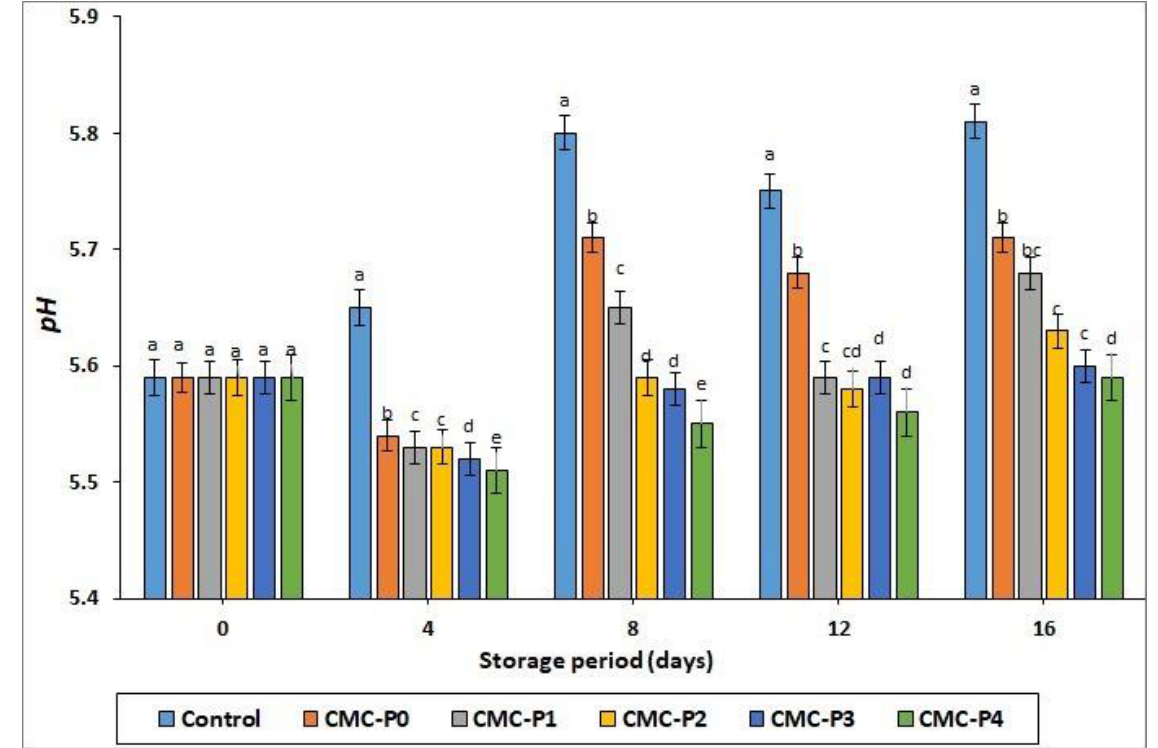
Figure 1. The impact of applied coatings on the pH values of chicken breast meat samples during storage at 2 °C for 16 days. Control : Uncoated chicken breast meat samples (soaked samples in sterile distilled water). CMC-P0 : CMC-coated chicken breast meat samples with 0% EPE. CMC-P1 : CMC-coated chicken breast meat samples with 1% EPE. CMC-P2 : CMC-coated chicken breast meat samples with 2% EPE. CMC-P3 : CMC-coated chicken breast meat samples with 3% EPE. CMC-P4 : CMC-coated chicken breast meat samples with 4% EPE. a–e : Within a column, different superscripts indicate significant differences ( p ≤